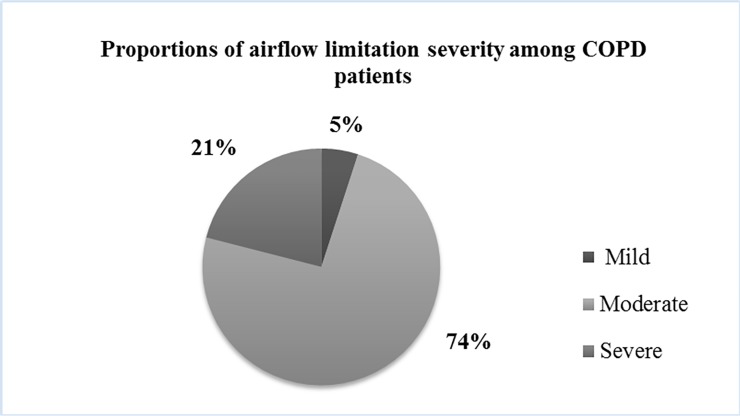
Severity of airflow limitation in COPD patients.